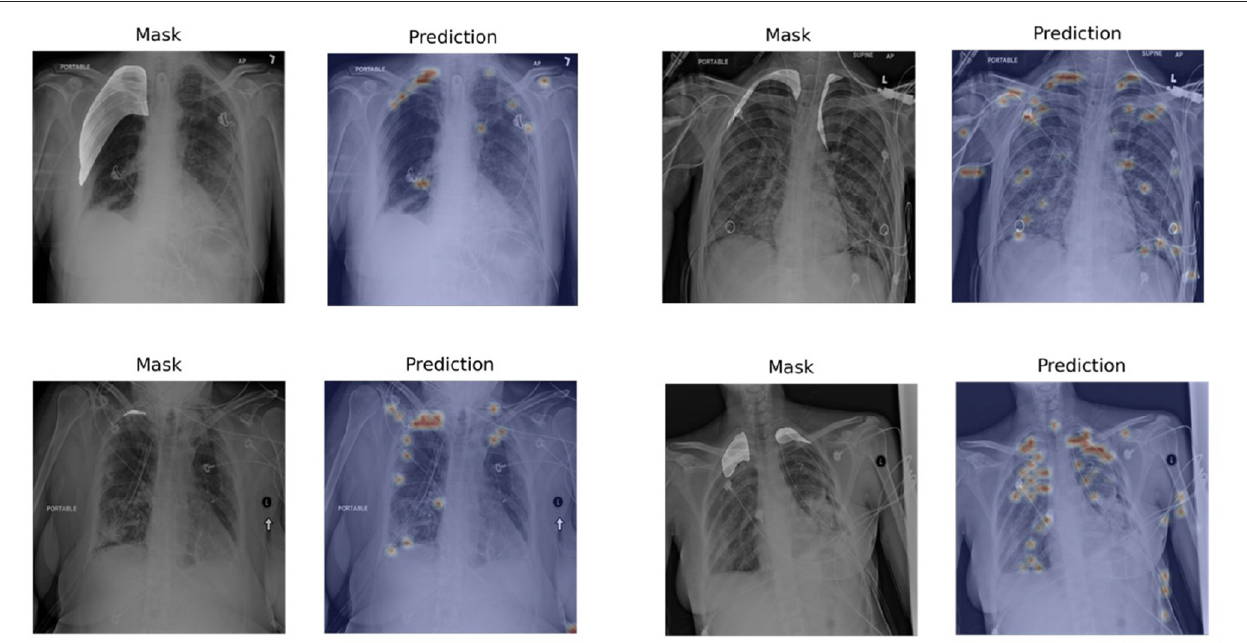
FIGURE 5 | Examples of segmentation visualization on the testing set. The visualization is generated by rendering the pixel-level outputs as heatmaps and overlapping on the original images. The left image in each pair is the original chest radiograph with highlighted masks and the right one is the segmentation visualization.